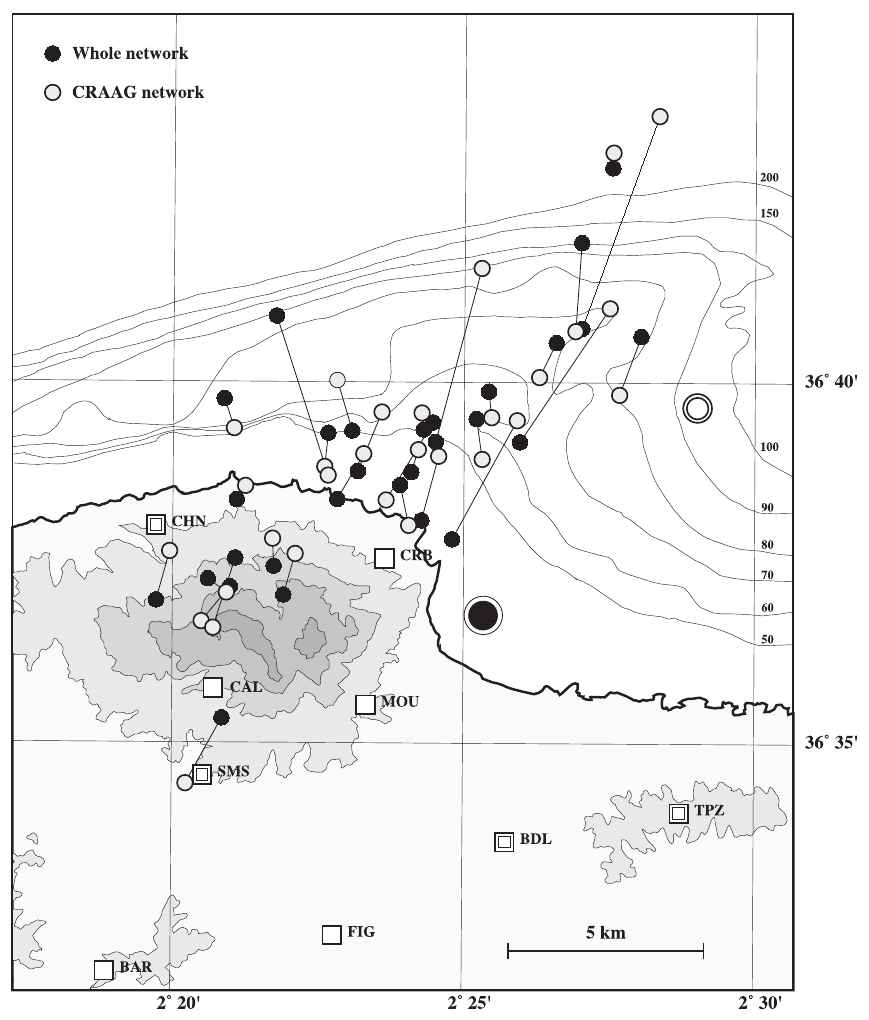
Fig. 9. Comparison of the locations calculated with the complete network (CRAAG + IPGS stations) and the locations calculated with the CRAAG stations only. Large open circle: epicenter of the master event; large solid circle: epicenter of the main